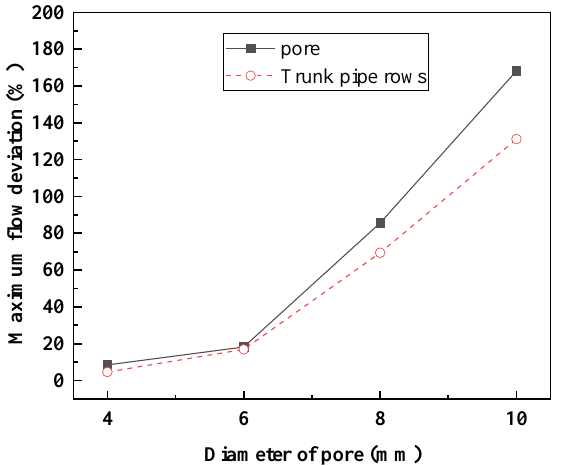
Figure 9. Maximum flow deviation for water diffuser under different perforated pore diameters.